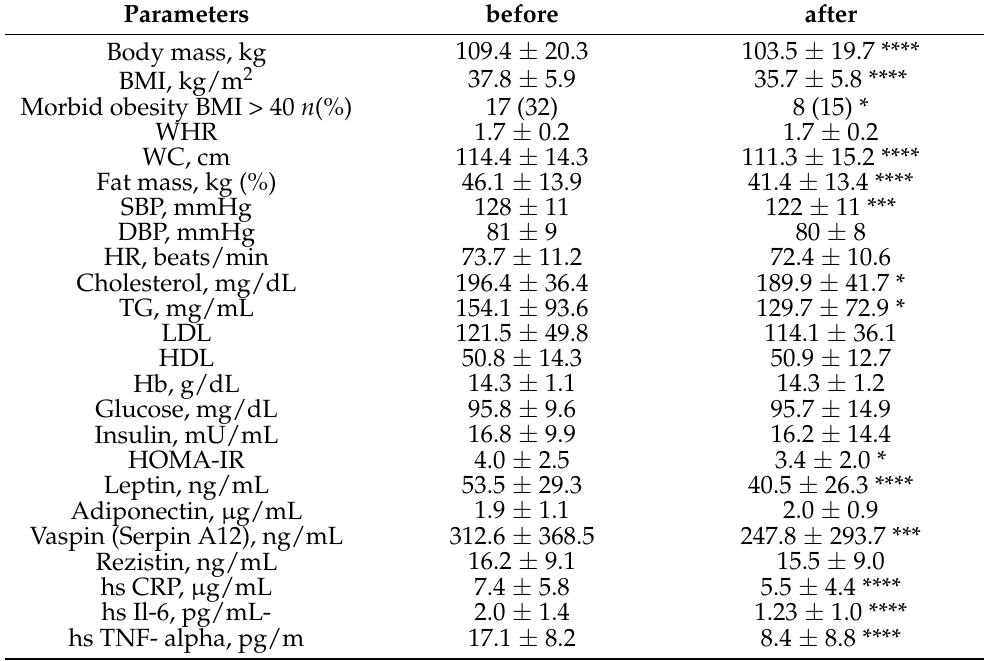
Table 4. Characteristics of patients before and after eight weeks of calorie restriction diet. The comparisons were made using the t -tests (Gaussian distribution: the paired test or the unpaired test; non-Gaussian